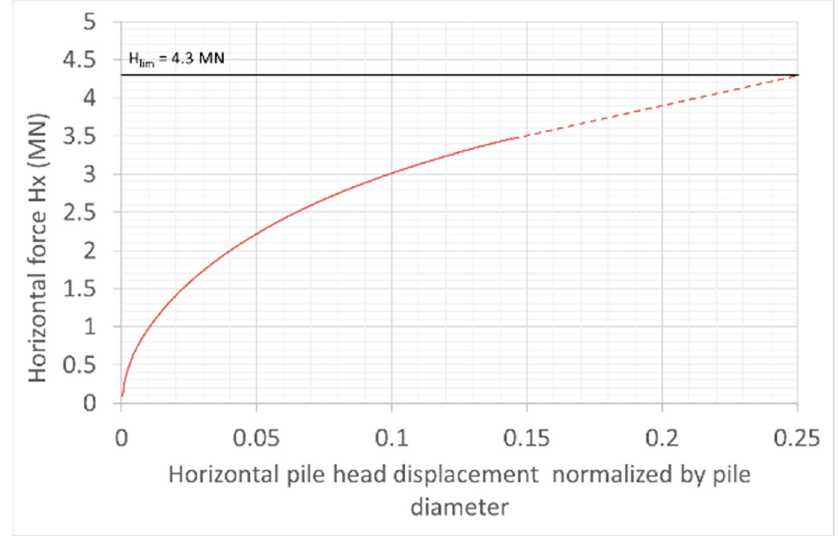
Figure 11. Force–displacement curve for the monotonic lateral loading of the pile.